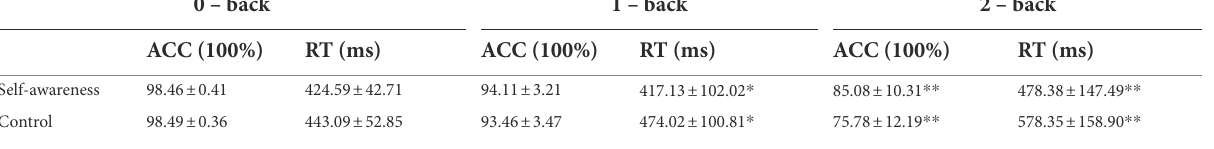
TABLE 1 Descriptive statistics of accuracy and response time (M ± SD).